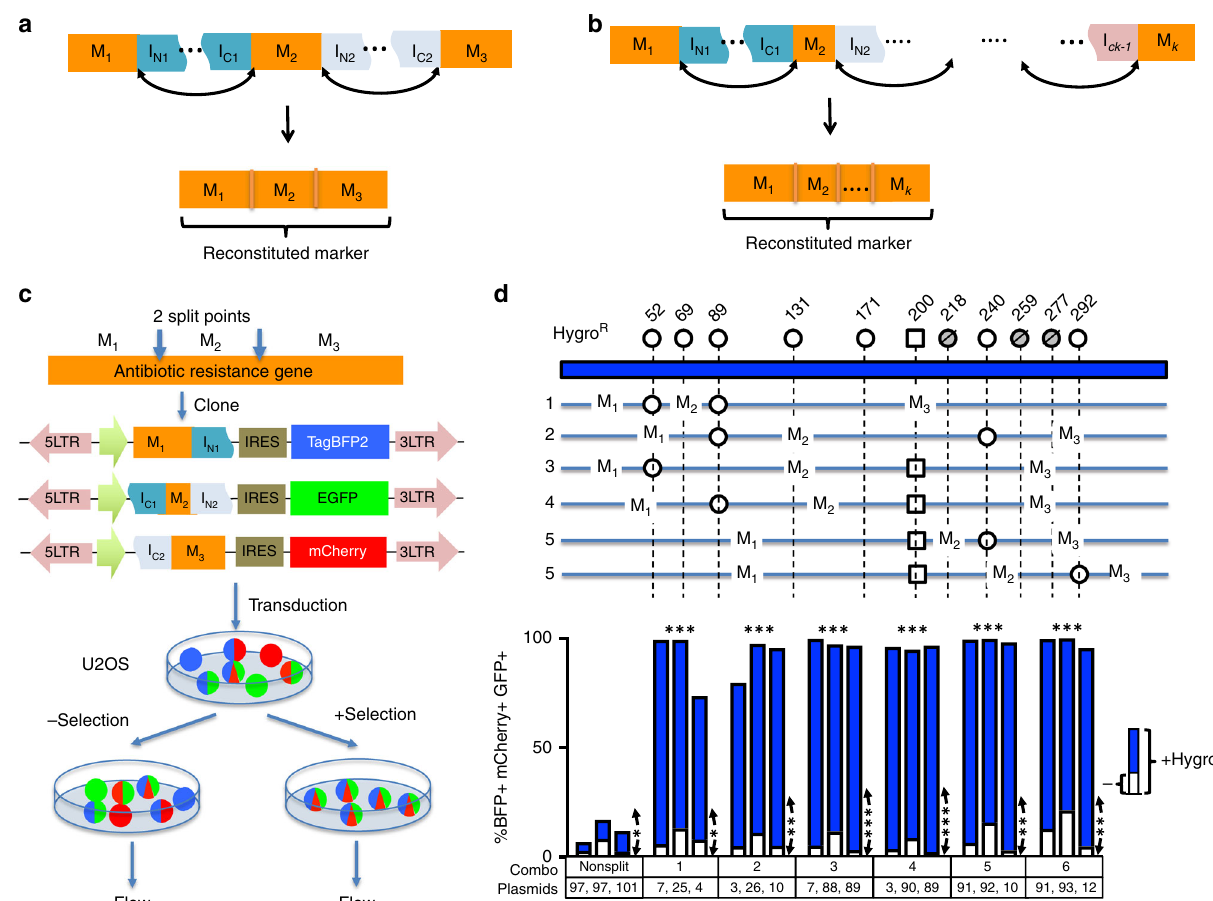
Fig. 4 Multi-split selectable markers for co-selection of three or more transgenic vectors. a Three-split Intres markers. A selectable marker is partitioned into three fragments. The fi rst marker fragment (M 1 ) is fused upstream of the N-terminal fragment of the fi rst split intein (I N1 ). The second fragment (M 2 ) is fused downstream of the C-terminal fragment of the fi rst split intein (I C1 ) and upstream of the N-terminal fragment of the second split intein (I N2 ). The third fragment (M 3 ) is fused downstream of the C-terminal fragment of the second split intein (I C2 ). The intervening split intein catalyzes the joining of the split fragments reconstituting the full selectable marker. b A design of a k -split selectable marker via an “ intein chain ” mechanism. The selectable marker is partitioned into k fragments that are reconstituted through protein trans-splicing mediated by intervening split inteins. c Split points identi fi ed from 2-split selectable markers were used in combination to produce 3-split selectable markers that were cloned into lentiviral vectors with different fl uorescent reporters. Cells were then transduced with viruses prepared from these vectors, split into selective or non-selective media. After selection, the cultures were analyzed by fl ow cytometry. d 3-split Hygromycin (Hygro) Intres. Top schematic shows the split points tested for Hygro R , with residue numbers of the last amino acid of the N-terminal fragments indicated above circle or square lollipops, representing Npu DnaE and Ssp DnaB inteins, respectively. Six designs of 3-split Hygromycin Intres were tested, each indicated with a numbered line with circle or square indicating the two split points used for each design. Column plot below shows the percentages of triple transgenic (BFP + GFP + mCherry + ) cells from the non-selective (white portion) and selective (total column height = white + blue) cultures for the 3-split Hygromycin Intres indicated by the numbers below. Horizontal asterisks indicate statistical signi fi cance by one-way ANOVA test on the percentages of triple-positive cells in the selected cultures of the speci fi c split marker vs those in the non-split marker (n.s., non-signi fi cant; * p < 0.05, ** p < 0.01, *** p < 0.001). Vertical asterisks indicate statistical signi fi cance by paired two-sided t -test on the percentages of triple-positive cells in the selected cultures vs non-selected cultures within each transfection group (n.s., non-signi fi cant; * p < 0.05, ** p < 0.01, *** p < 0.001)